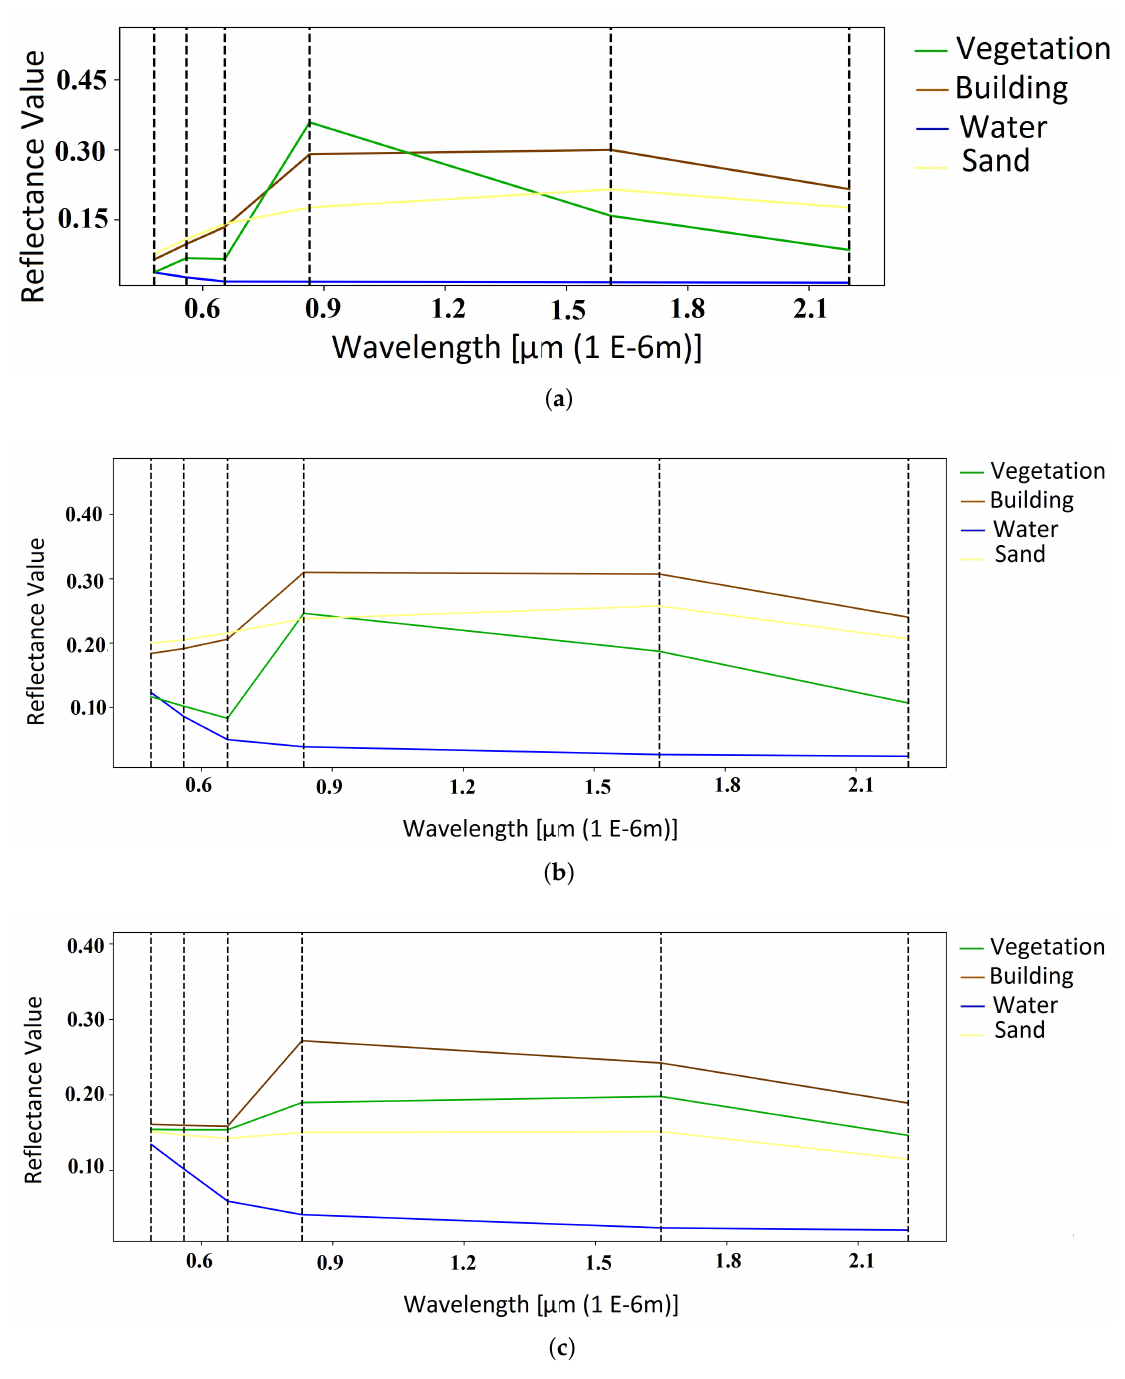
Figure 5. Spectral signature graphs of main land covers analyzed in the Ebro Delta from different dates and Landsat sensors: ( a ) OLI Landsat image captured on 10 September 2014. ( b ) ETM+ Landsat image captured on 4 May 2014. ( c ) TM Landsat image captured on 14 March